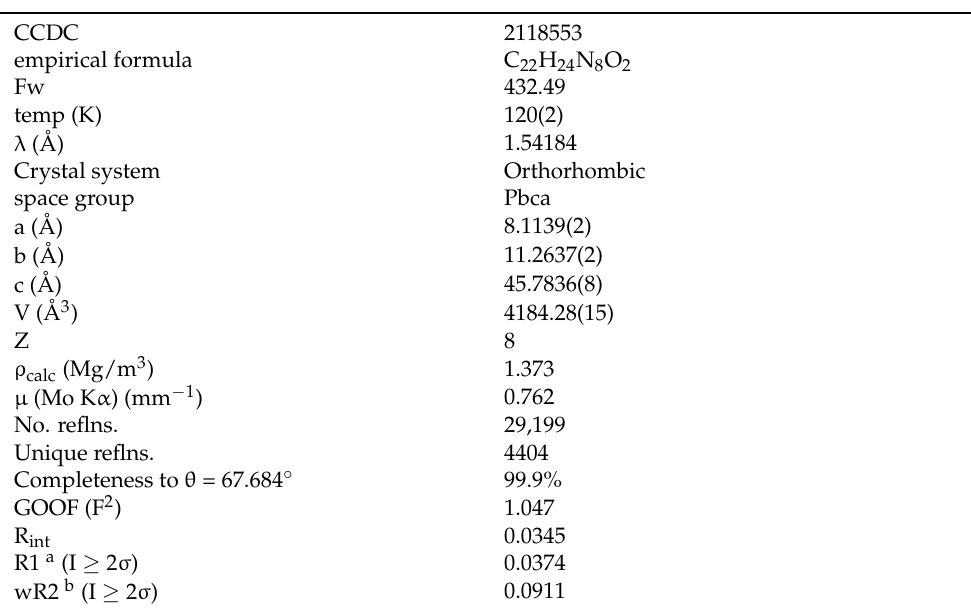
Table 1. Crystal Data of 4